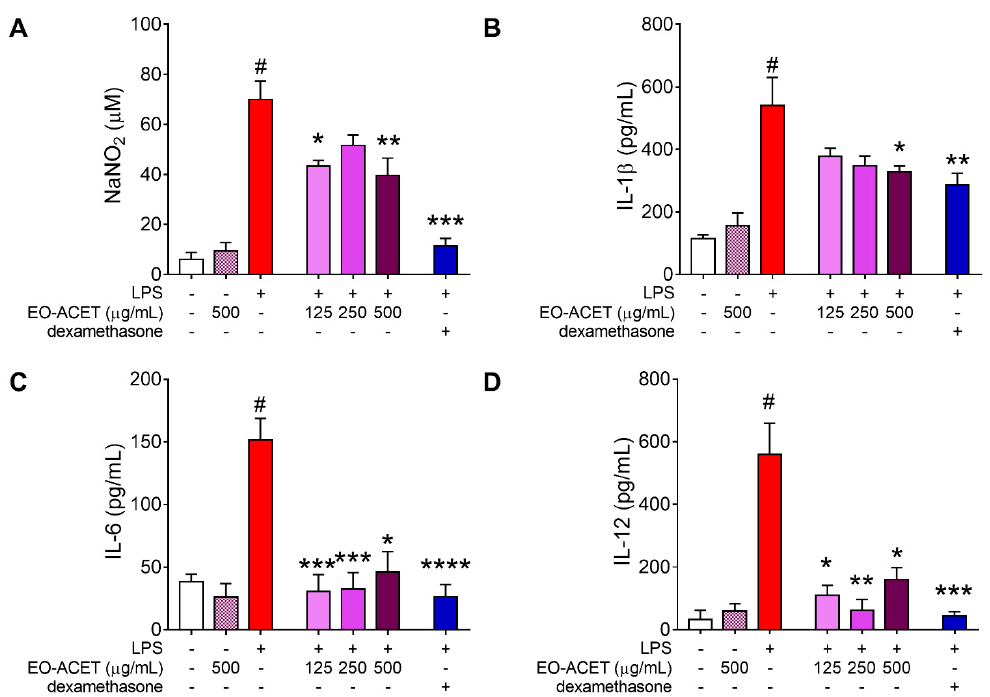
Figure 4. Pro-inflammatory factors in RAW 264.7 cells stimulated by LPS and treated with Euterpe oleracea ethyl acetate fraction (EO-ACET). Levels of nitrite ( A ) and cytokines ( B – D ) in culture supernatants of cells treated with EO-ACET (purple columns) or dexamethasone (blue column), 100 µM. Data represent the mean ± standard deviation of the experiment performed at least in triplicate. # p < 0.001 compared with the group without stimulation or treatment (white column); * p < 0.05, ** p < 0.01, *** p < 0.001, **** p < 0.0001 when compared with the stimulated and untreated group (red column) after Kruskal–Wallis analysis, followed by Dunn’s multiple comparisons tests.